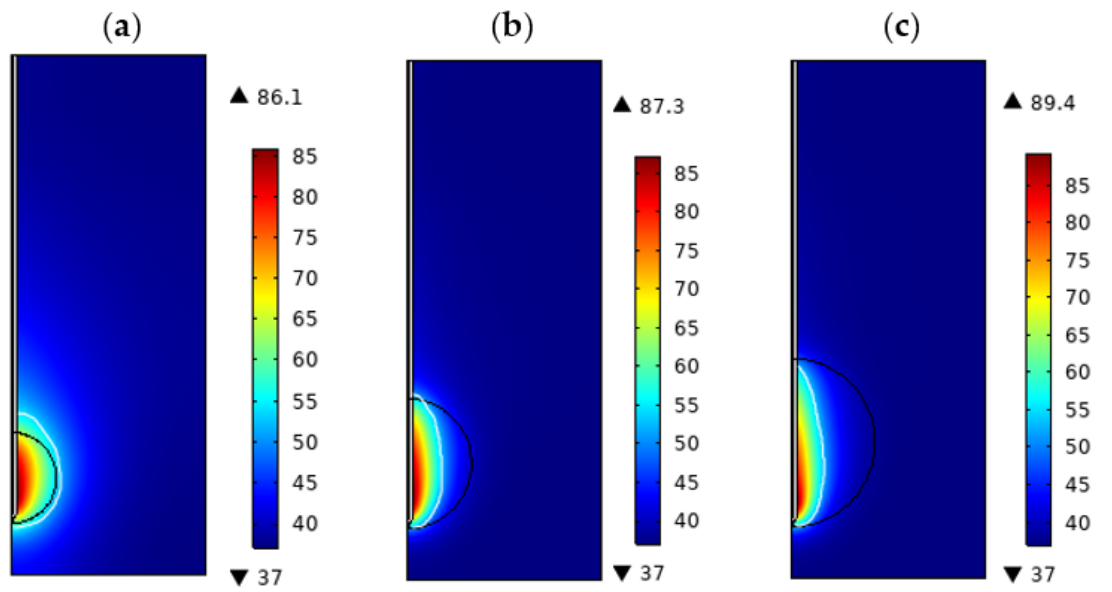
Figure 3. Temperature distribution of porous lung tissue at different tumor diameters (P = 10 W, t = φ φ = 0.7, t = 0.6): ( a ) d = 1.4 cm, ( b ) d = 2.0 cm. ( c ) d = 2.6 cm. 300 s, l t = 300 s, φ l = 0.7, φ t = 0.6): ( a ) d = 1.4 cm, ( b ) d = 2.0 cm. ( c ) d = 2.6